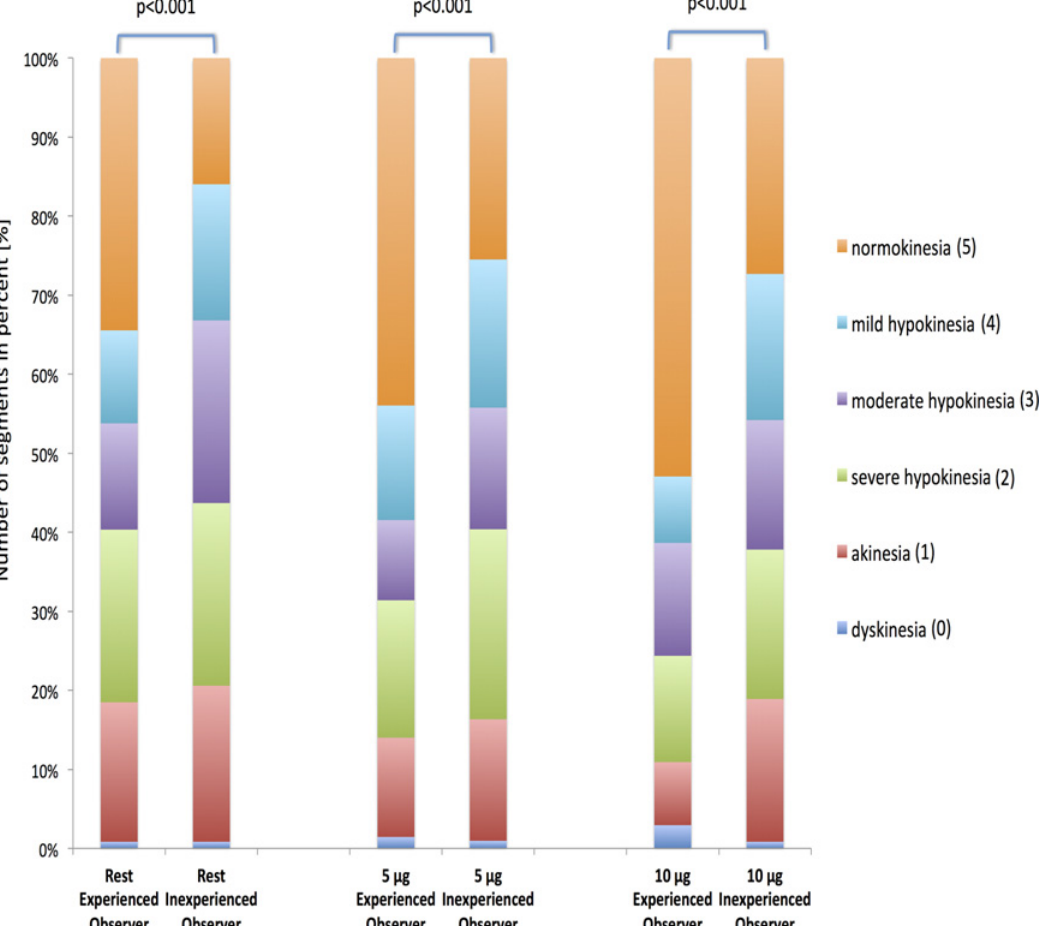
Fig 3. Comparison of visual analysis performed by one experienced and one inexperienced observer. The figure shows the results of the visual analysis for one experienced and one inexperienced observer. Wall motion was classified as normal (5), mild hypokinesia (4), moderate hypokinesia (3), severe hypokinesia (2), akinesia (1) or dyskinesia (0). Wall motion is presented regarding the individual stress level. Visual analysis was significantly different between the two